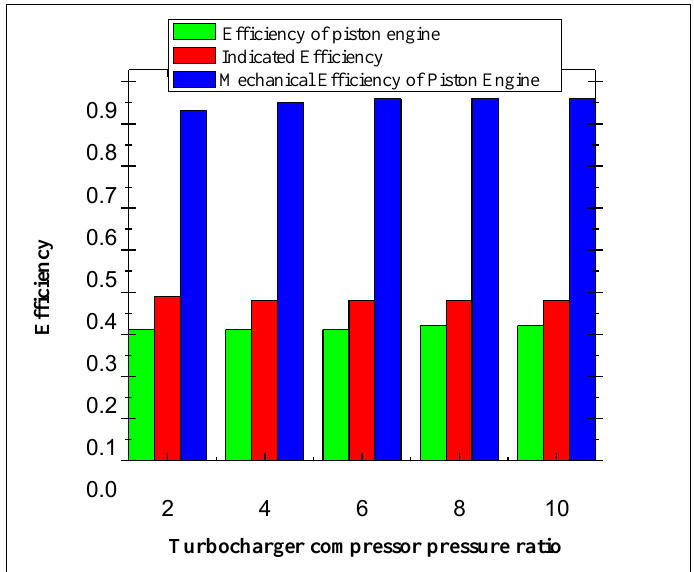
Figure 4. Engine efficiency